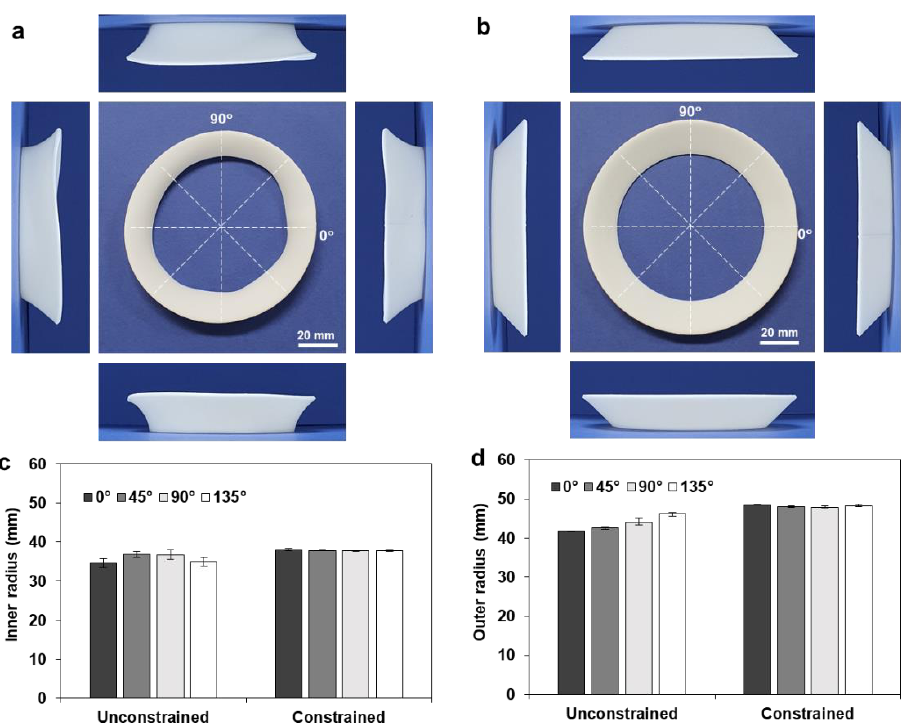
Figure 9. Comparison of the roundness of the deformed annulus ( r o = 60, w = 20 mm): ( a ) unconstrained deformation; ( b ) constrained deformation; ( c ) comparison of the inner radius ( r i *); ( d ) comparison of the outer radius ( r o *).